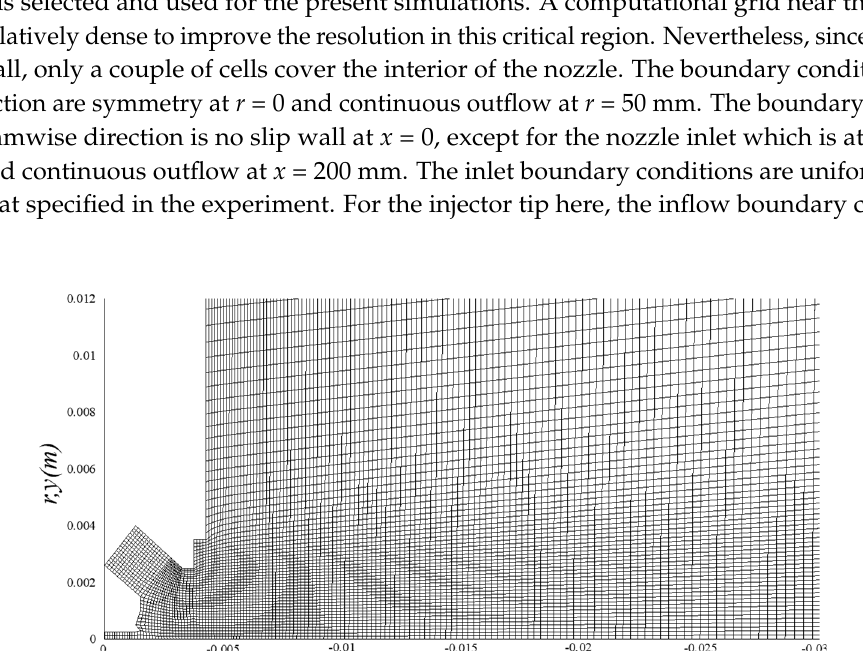
Figure 6. Streamwise velocity with non-swirling atomizing air.